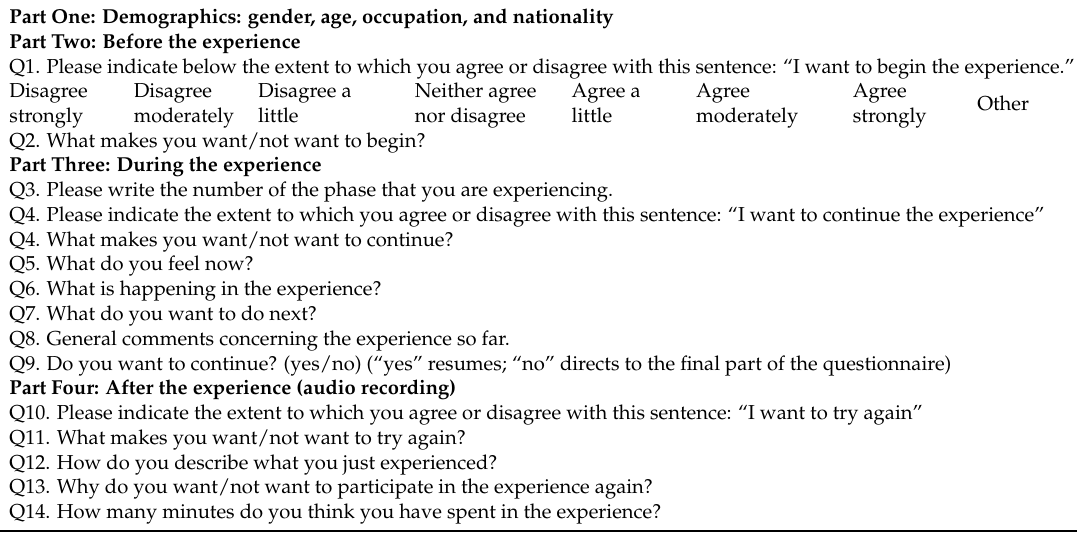
Table 1. Engagement